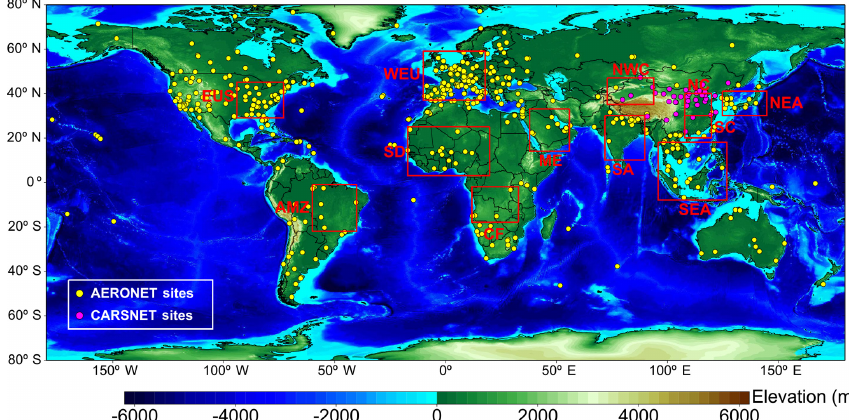
Figure 1. Geographical locations of the AERONET (yellow dots) and CARSNET sites (magenta dots) used in this work. The red boxes represent the 12 regions of interest selected in this study: northeastern Asia (NEA), northern China (NC), southern China (SC), southeastern Asia (SEA), northwestern China (NWC), southern Asia (SA), Middle East (ME), western Europe (WEU), Sahara desert (SD), central Africa (CF), eastern United States (EUS) and Amazon zone (AMZ).